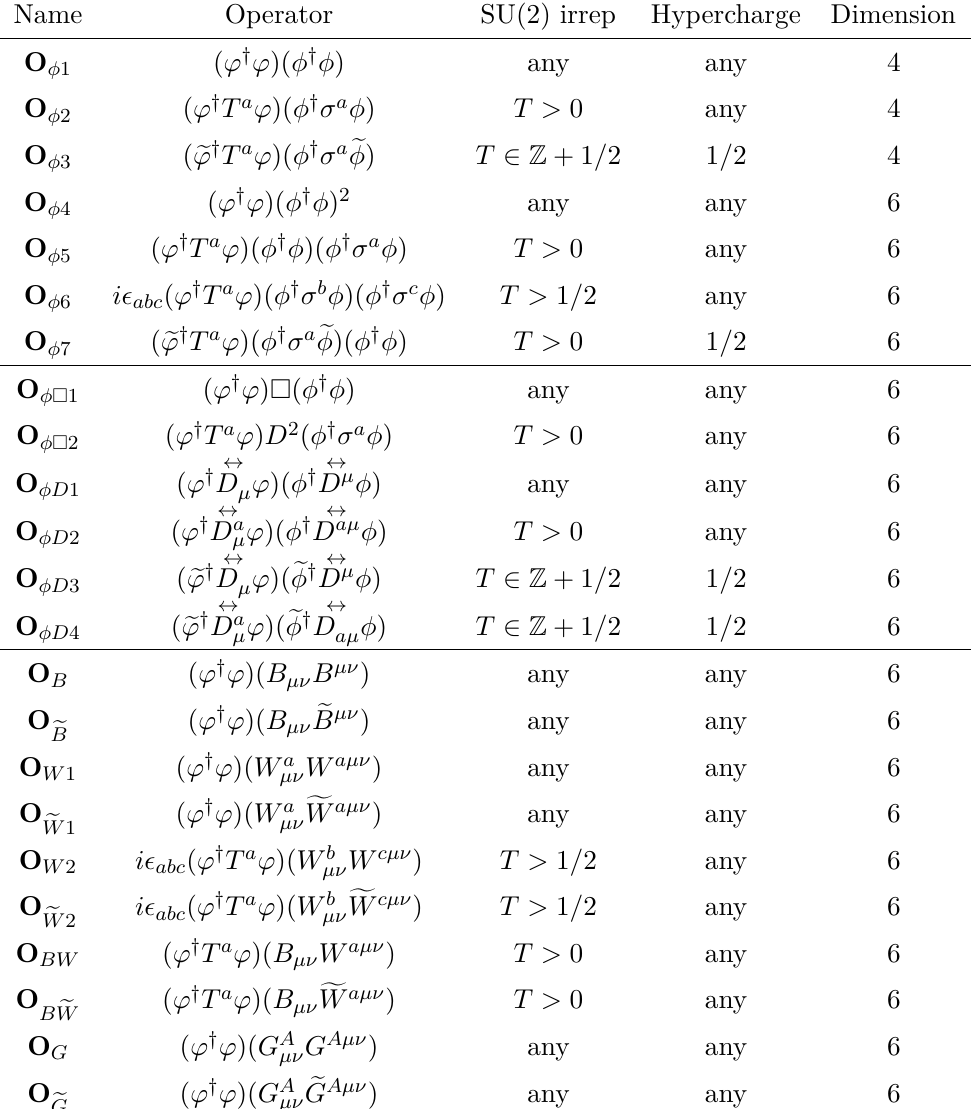
Table 4 . Basis of operators of dimension ≤ 6 with two scalar DM multiplets and SM bosons